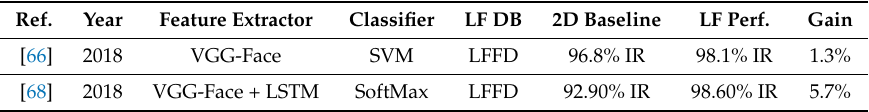
Table 7. Summary of deep-learning-based face recognition methods. Abbreviation used in this